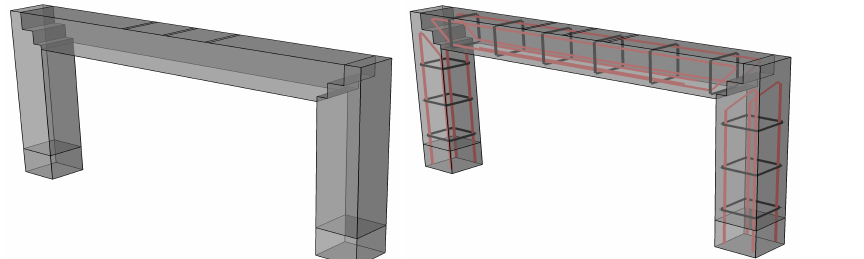
Figure 15. F6, Rebar layout and geometrical dimensions.